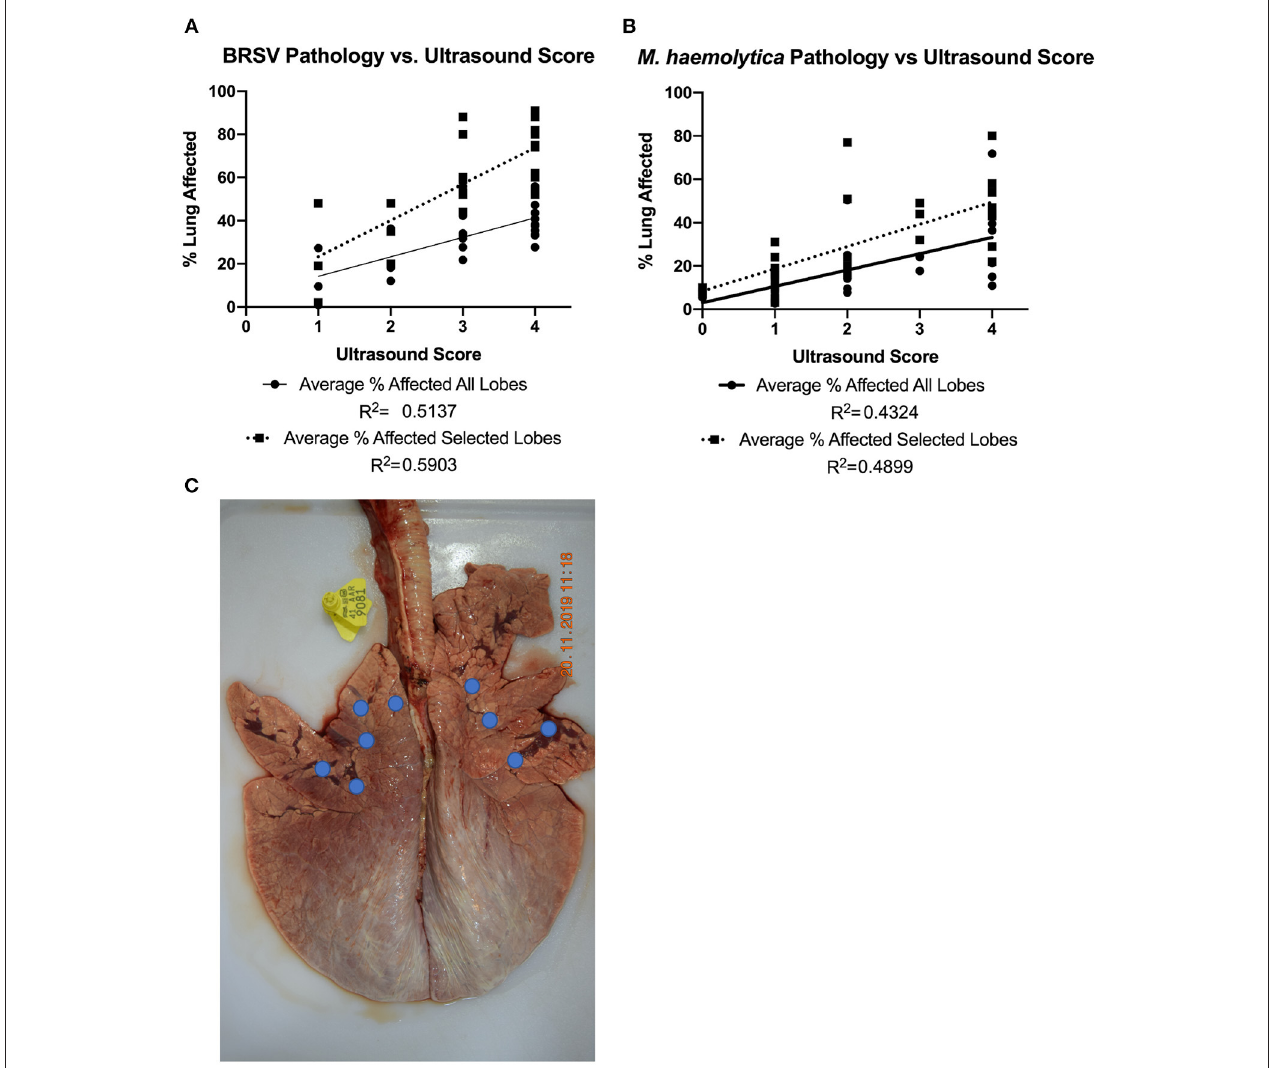
FIGURE 8 | Gross lung pathology on necropsy plotted against ultrasound score on necropsy. In both BRSV-infected (A) and M. haemolytica –infected calves (B) , the lungs were divided into 11 lobes and scored based on percentage of lung affected by gross lesions. The average percent affected across all lobes was plotted in addition to an average across the five lobes imaged via ultrasound. The approximate ultrasound locations for both the left and right sides of the lung are shown (C) . Because the entire lung field was examined via TUS, the average of the lobes that were imaged was plotted separately. In both disease models, there was a correlation between gross lung pathology on necropsy and ultrasound score and the correlation increased when only the lobes with the TUS locations were